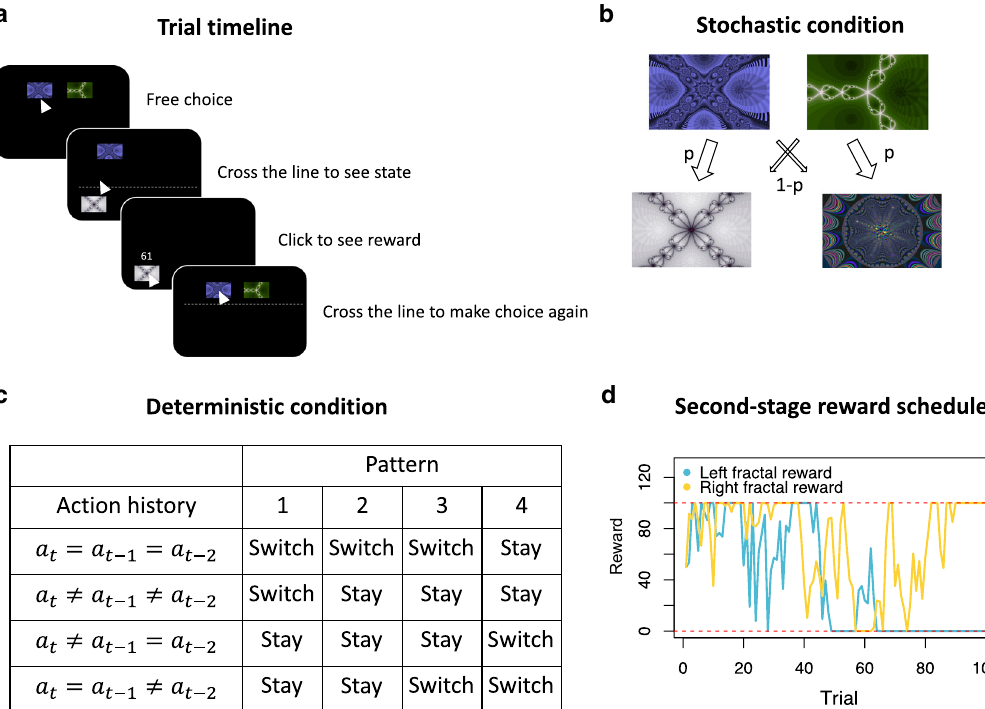
Fig. 1 Experimental task and design. a Choice-trial timeline. Subjects chose between the two top fractals ( fi rst stage). To reveal the outcome (second stage), subjects needed to move the mouse below an invisible line on the screen (here shown with a dotted line). To receive the resulting reward, subjects clicked on the revealed bottom fractal. To begin the next trial, subjects moved the mouse back up above another invisible line. The positions of all fractals were fi xed from trial to trial within a block. b In the stochastic condition, one of the top fractals is more likely to lead to one of the bottom fractals (common transition), and the probabilities are reversed for the other pair. c In the deterministic condition, the switch between the bottom fractals from trial to trial is determined by the choices of the top fractals in the three previous trials. Here we show the four deterministic patterns used in the experiment. a t is the top choice in trial t ; the action history column describes the four possible top-choice histories. Each pattern (columns 1 – 4) is a set of outcomes corresponding to one of these histories. These outcomes include either stay (the same bottom fractal appears on this trial as in the previous trial) or switch (the bottom fractal switches from the previous trial). See Supplementary Information for a detailed description of the patterns. d Example of the second stage reward schedule: each bottom fractal had an independent drifting reward following a Gaussian random walk, with rewards restricted to the interval between 0 and 100. Each subject had independent, randomly generated reward schedules. The fractals pictured here are for illustration only; the originals are available in the OSF repository. Source data are provided as a Source Data fi